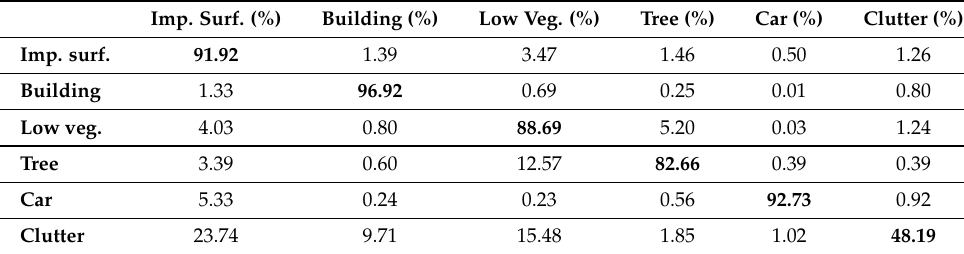
Table 9. Confusion matrix produced from test data predictions using the model M16*. Imp. Surf. (%)